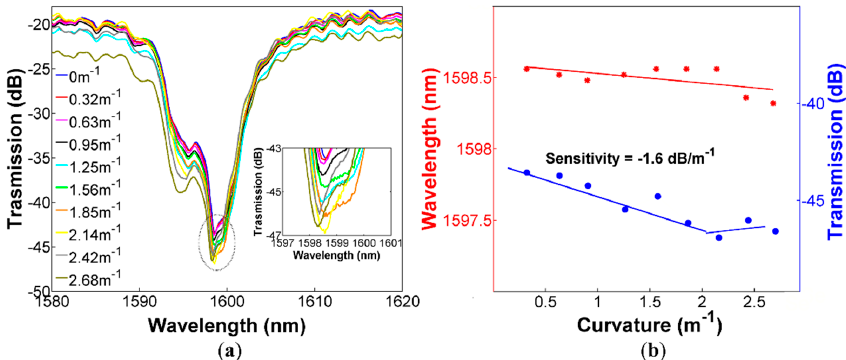
Figure 4. ARROW sensor without PDMS ( a ) Spectral response of the sensor for curvatures from 0 to 2.68 m − 1 ; ( b ) Dip wavelength shift and transmitted intensity changes as a function of the applied